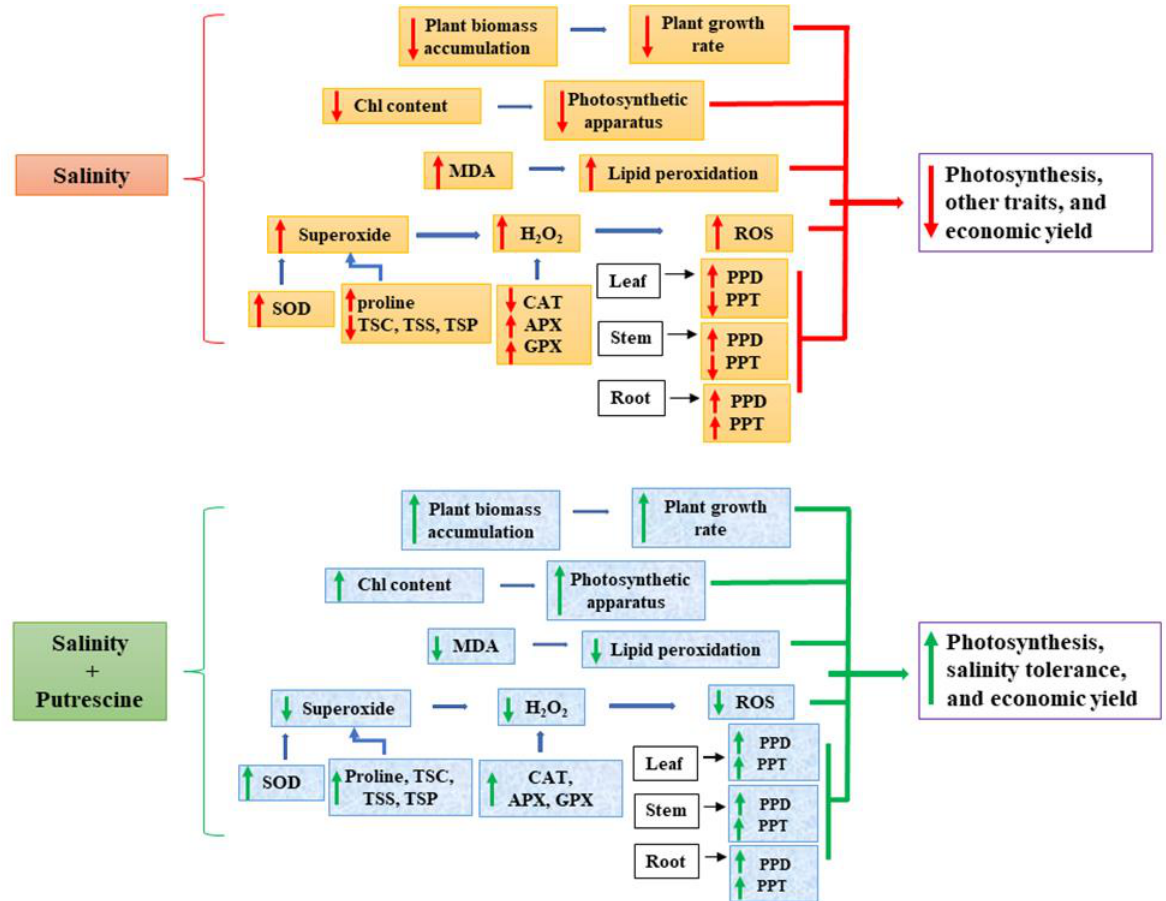
Figure 8. Schematic representation of salinity-induced growth inhibition and improvement of growth by exogenously Put treatment. Chl, chlorophyll; H 2 O 2 , hydrogen peroxide; ROS, reactive oxygen species; Pro, proline; TSC, total soluble carbohydrate; TSS, total soluble sugar; TSP, total soluble protein; SOD, superoxide dismutase; CAT, catalase; APX, ascorbate peroxidase; GPX, guaiacol peroxidase; MDA, malondialdehyde.